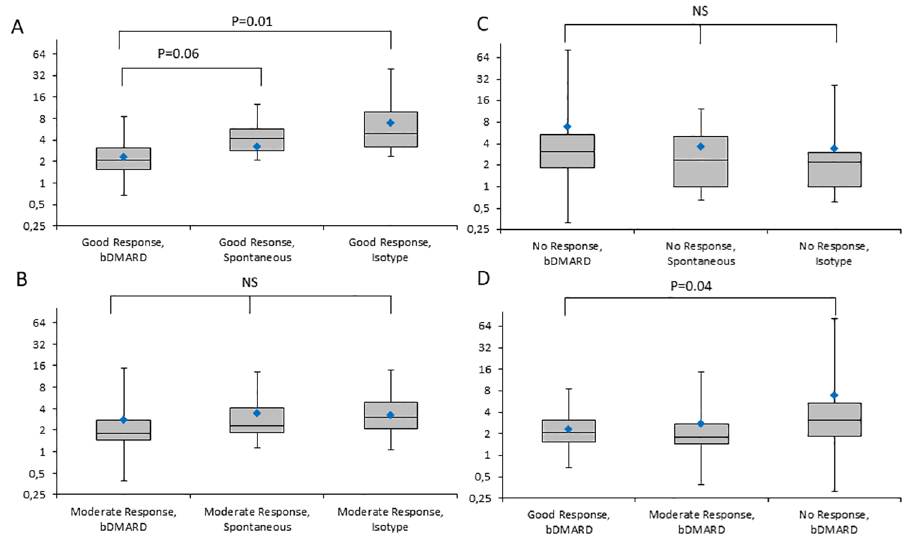
Fig 3. Box plots illustrating changes in fold changes in explant production of IL-6 with regards to in vitro interventions and EULAR responses. ‘Diamond’ corresponds to mean fold change of IL-6. Only statistically significant P-values are depicted. a) bDMARD treated samples, b) spontaneous release, c) isotype control, d) good responders, e) moderate responders, f) none responders. bDMARD = in vitro added biologic disease modifying anti-rheumatic drug; IL-6 = interleukin 6; pg = picogram; Isotype = isotype matched IgG. NS = statistically non-significant, P >